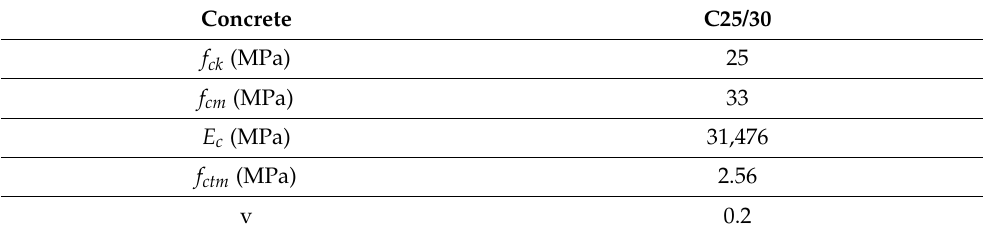
Table 1. Material properties of ordinary concrete.